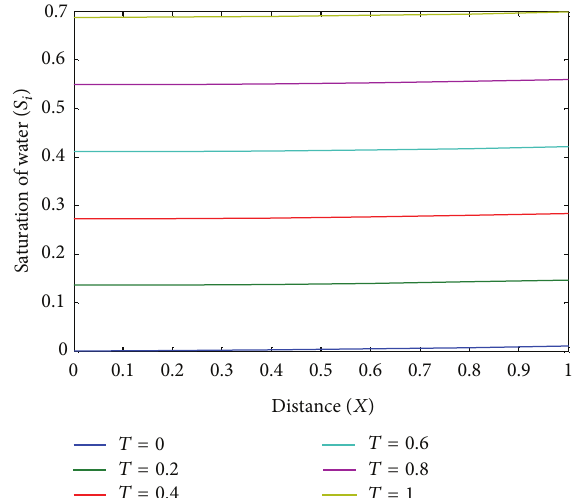
Figure 4: The plot of distance ( 𝑋 ) versus saturation of water ( 𝑆 𝑖 ) for different values of time ( 𝑇